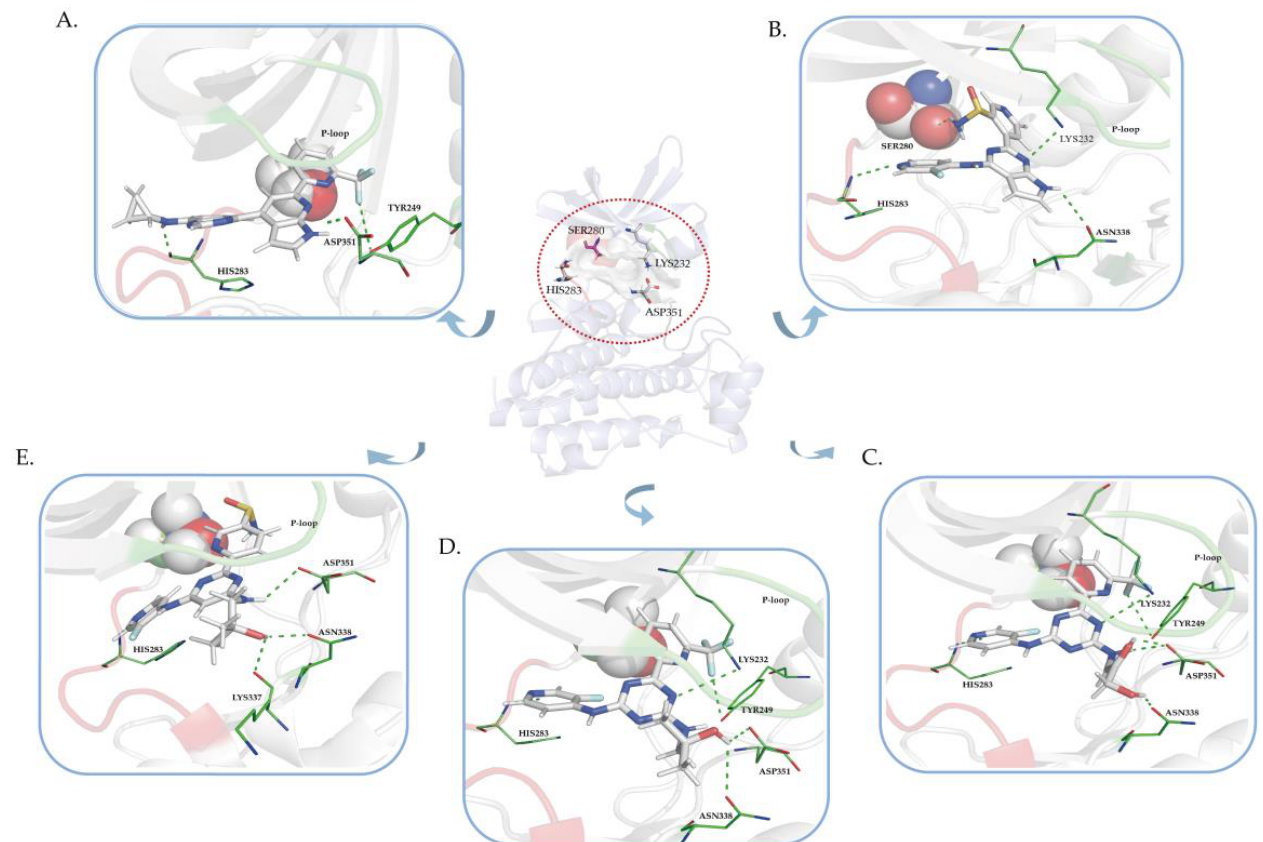
Figure 5. The input conformations of H1, S1, W1, W8 and S1W8 for MD simulation are displayed in figures A, B, C, D, E, respec- tively.